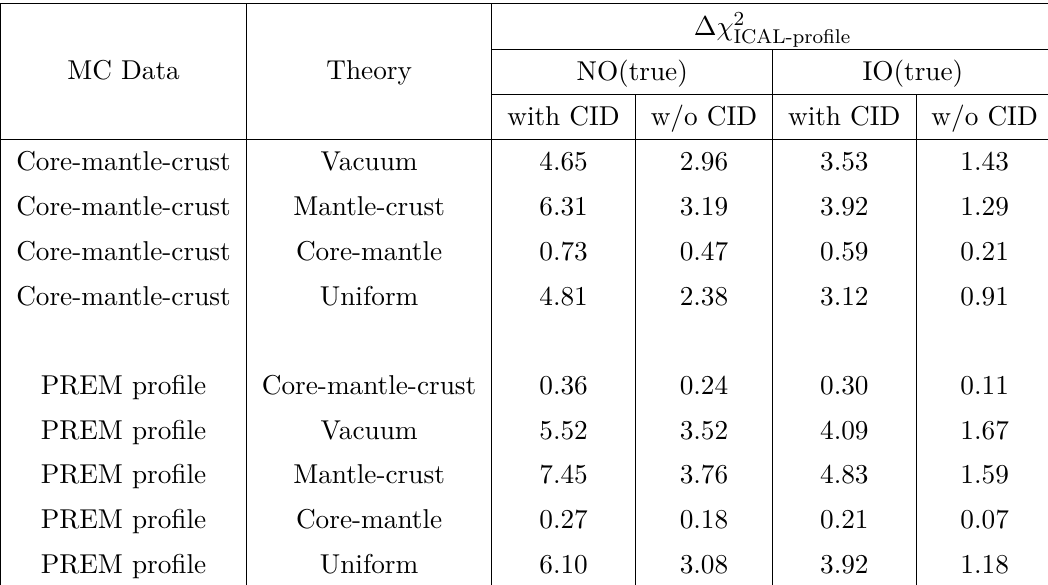
Table 6 . Ruling out the alternative profiles of Earth at the median ∆ χ 2 level. We marginalize over oscillation parameters sin 2 θ , ∆ m 2 , and mass ordering in theory, whereas remaining oscillation 23 eff parameters are kept fixed at their benchmark values as mentioned in table 2. The third and fourth (fifth and sixth) columns show results considering NO (IO) as true mass ordering in data. The results in the third and fifth (fourth and sixth) columns are with (without) the charge identification capability of